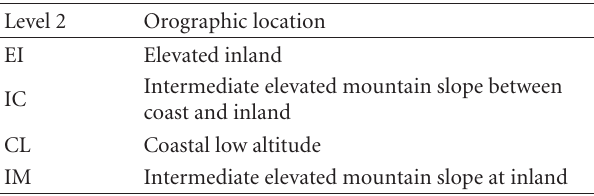
Table 5: Classification of air quality monitoring stations, namely, Level 2, according to their topographic environment.